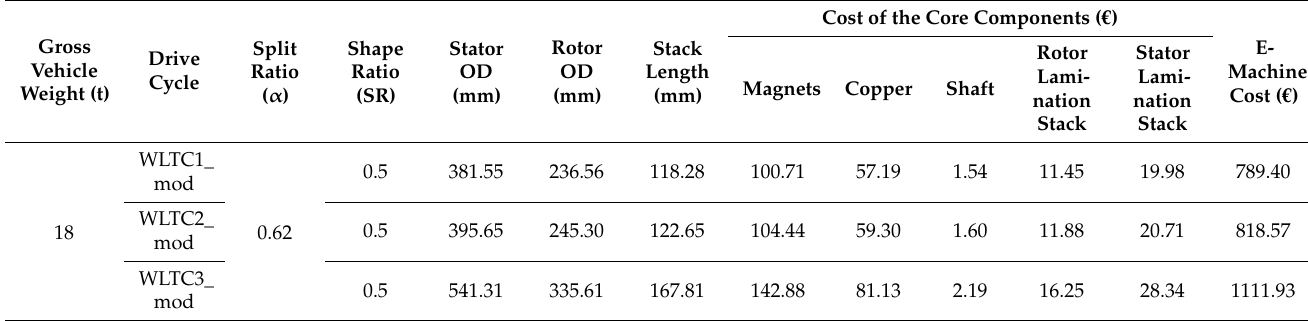
Table 10. Overview of the most cost-effective e-machines for different use cases in the 18 t vehicle